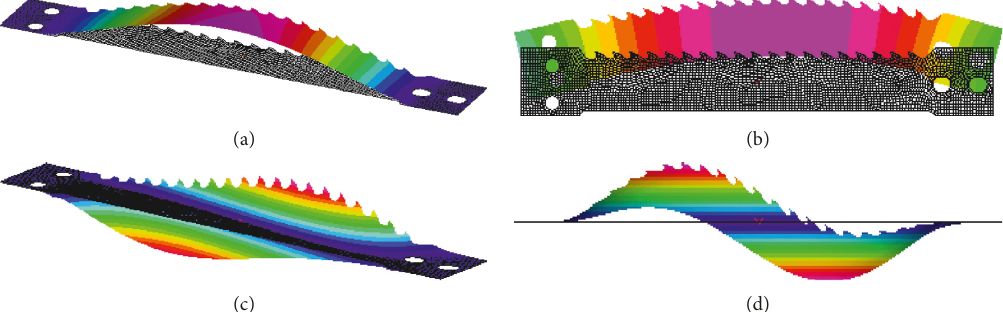
Figure 5: Natural vibration type of the tooth blade: (a) type 1, bending; (b) type 2, bending; (c) type 3, twist bending; (d) type 4, two span twist bending.